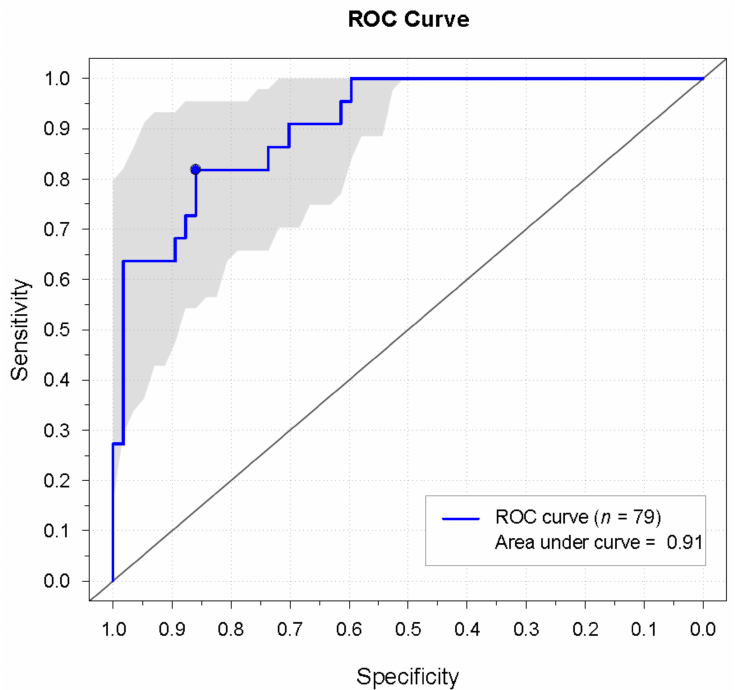
Figure 6. The receiver operating characteristic (ROC) curve generated from the final logistic regres- sion model. The blue point marks the place on the curve where sensitivity and specificity are highest. This optimal point on the curve was used to derive the cut-off value, above or below which diagnosis is either confirmed or rejected, respectively. The gray area surrounding the ROC curve represents the 95% confidence